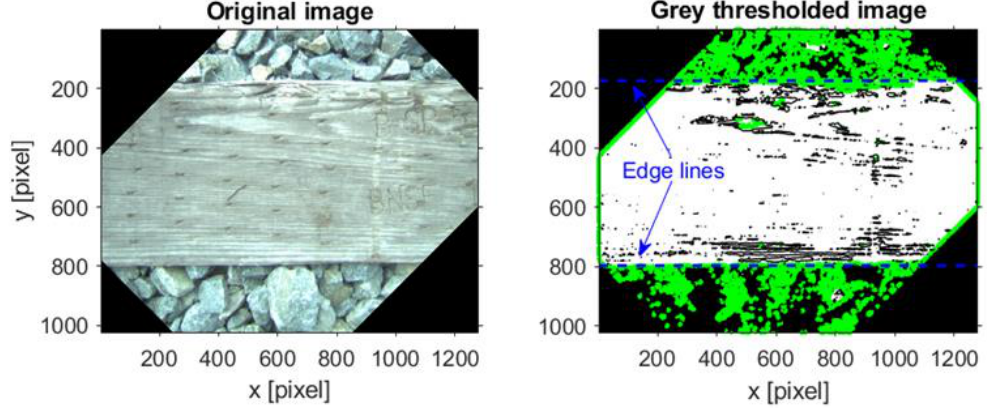
Figure 11. Estimation of the tie’s width in the pixel